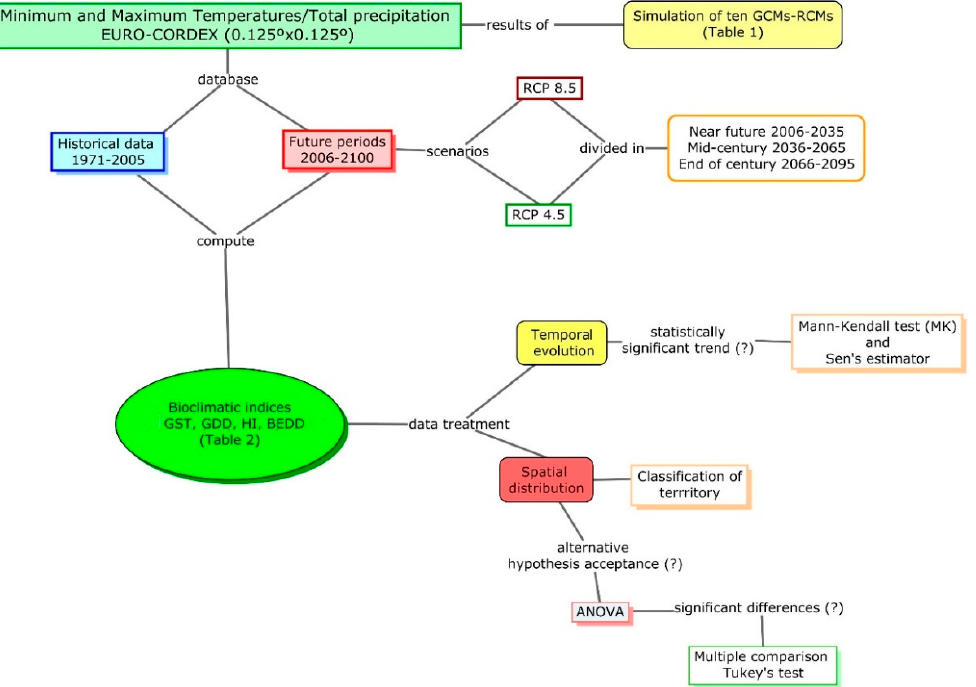
Table 3. Mean and coefficient of variation for each bioclimatic index (°C units) and for each period and